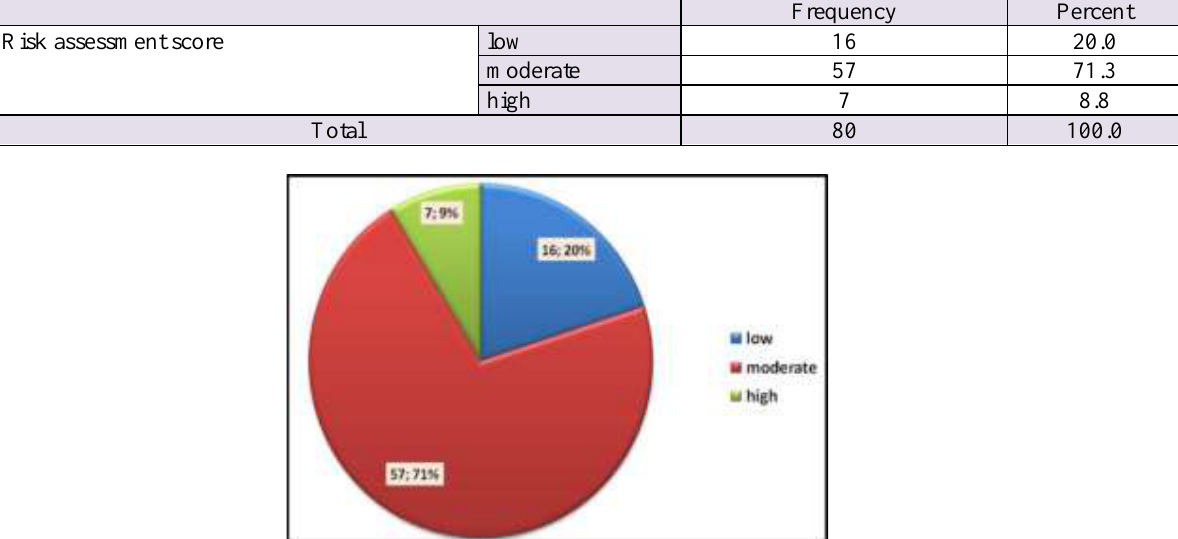
Table (2): Distribution of the participants according to their risk assessment score.